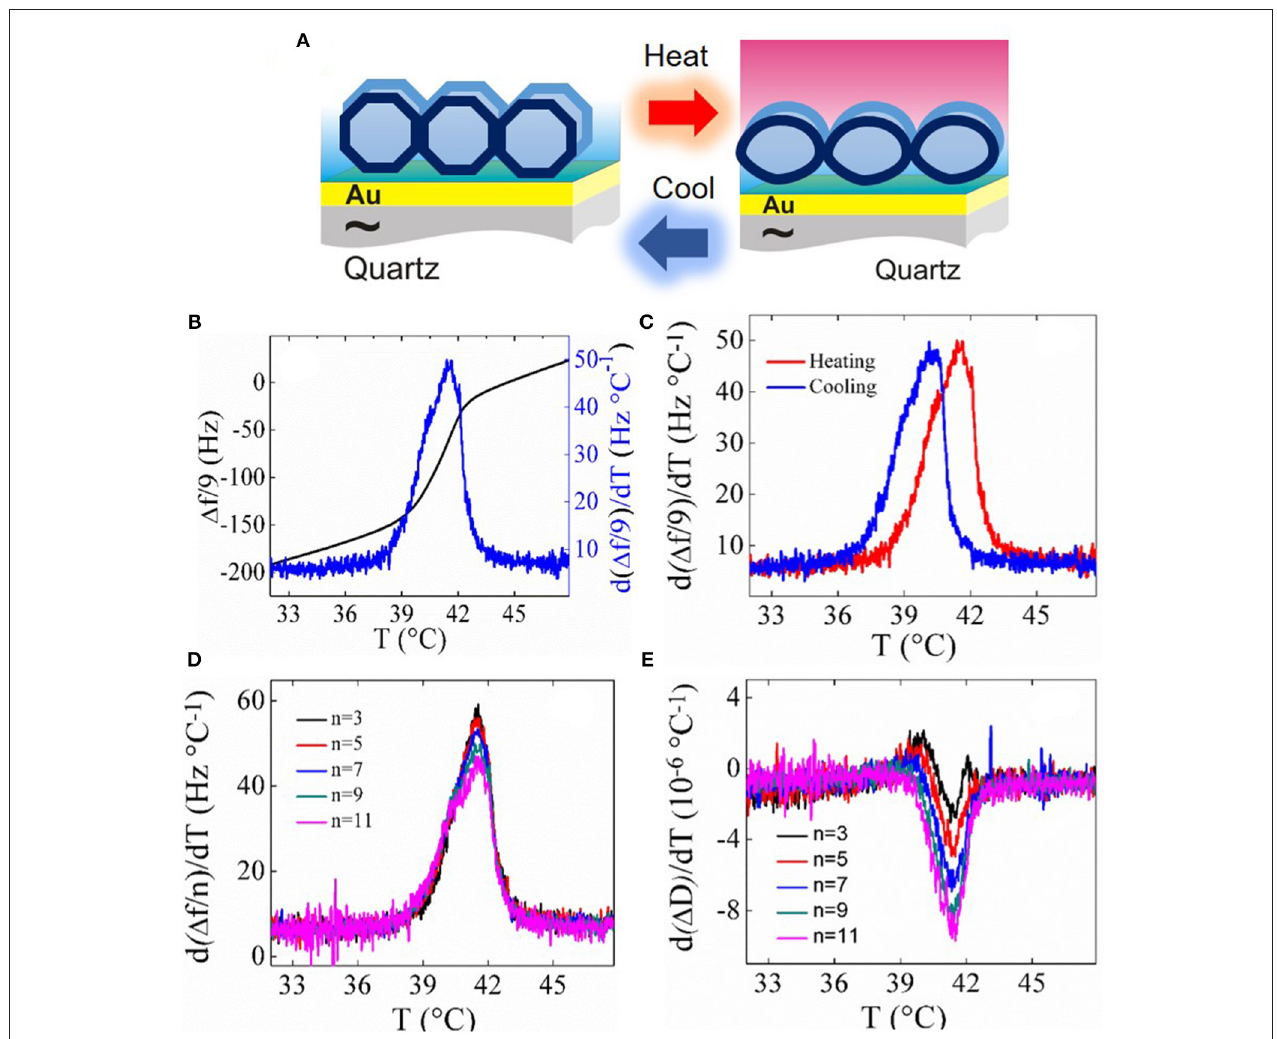
FIGURE 1 | (A) Schematic of changes in SVLs upon the main phase transition (B) temperature dependence of the frequency shift d ( 1 f /9)/ dT (black solid line) and its first-order derivative (blue solid line) of a DPPC SVL upon heating at 0.2 ◦ C/min. (C) Hysteresis observed between heating and cooling runs at the same rate. (D) Overtone dependence of d ( 1 f /n)/ dT and (E) overtone dependence of d 1 D / dT